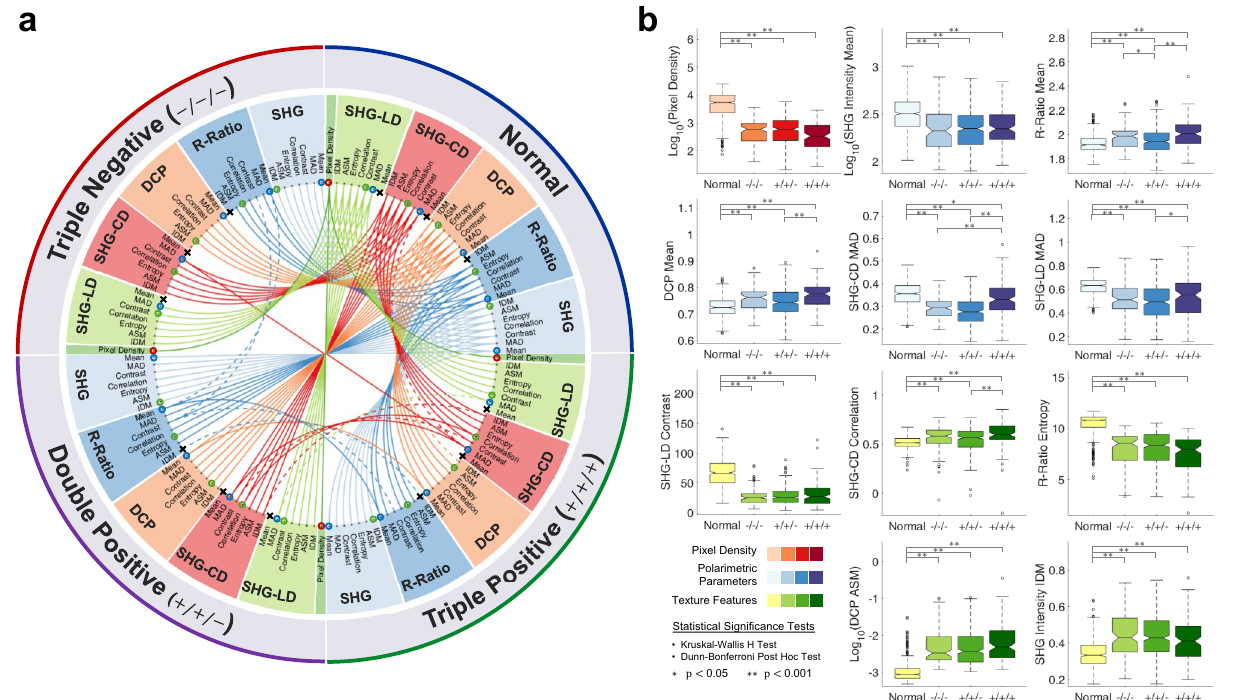
Figure 4. Parameter multiple comparisons testing. ( a ) Circular plot of all multiple comparisons test between all four groups. Kruskal–Wallis H test and Dunn–Bonferroni post hoc test were performed. The dashed links indicate significant differences ( 0.001 < p < 0.05 ), while solid links depict highly significant differences ( p < 0.001 ). All non-significant differences are omitted. It is evident that normal tissue is highly significantly different from all tumor groups across most of the measured parameters. Parameters that are not significantly different between normal and any of the tumor groups are denoted by x’s and removed from further investigation. ( b ) Boxplots of selected parameters show detailed differences between all four considered groups. Color of the plots correspond to small circles around parameters in a. It is evident that triple positive is the most different tumor group from normal. Colored areas highlight the interquartile range and the center line denotes the median of the data. The whiskers extend to 1.5 × interquartile range, and the circles show the